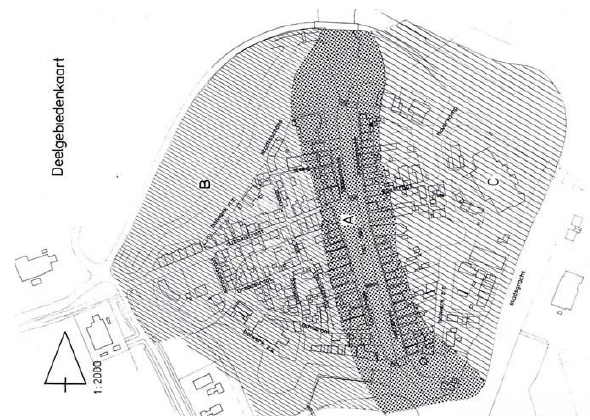
Figure 3. Sub - Areas of the Z oning